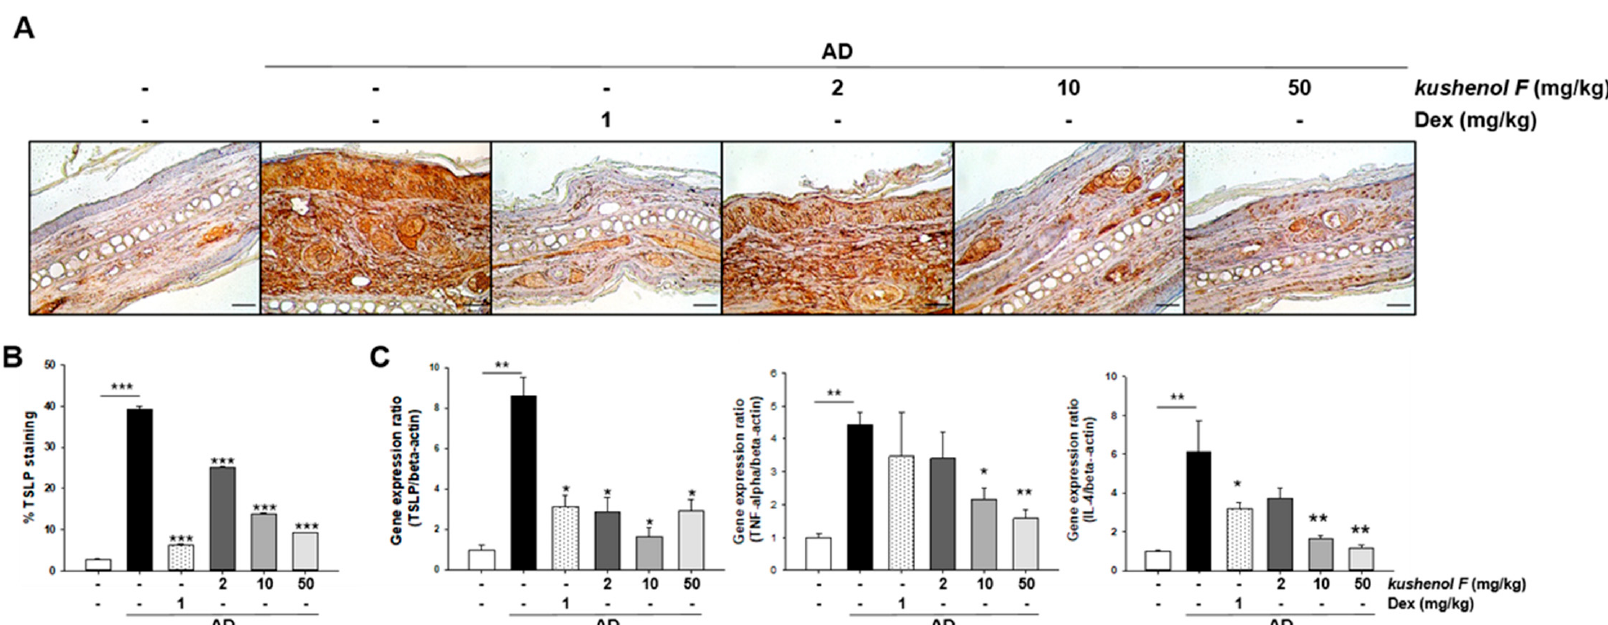
Figure 4. TSLP and cytokine expression analysis of dorsal skin lesions in DFE/DNCB-treated atopic dermatitis mice treated with kushenol F. ( A ) Paraffinized ear sections were examined using the TSLP antibody. Scale bar = 10 µ m. ( B ) TSLP expression levels were quantified using ImageJ software. ( C ) TSLP, TNF- α and IL-4 mRNA expression levels in the ear skin of kushenol F-treated mice. Data are presented as the mean ± SD ( n = 5). * p < 0.05, ** p < 0.01 and *** p < 0.001 vs. control. TSLP, thymic stromal lymphopoietin; DFE, Dermatophagoides farinae extract; DNCB, 1-chloro-2,4-dinitrochlorobenzene.